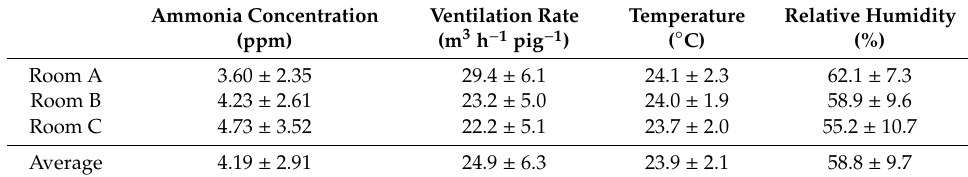
Figure 3. Time–series graphs of ammonia concentration, ventilation rate, temperature, and relative humidity in ( a ) Room A, ( b ) Room B, and ( c ) Room C. Table 4. Summary of ammonia concentration, ventilation rate, temperature, and relative humidity (mean ± standard deviation) in Rooms A–C.